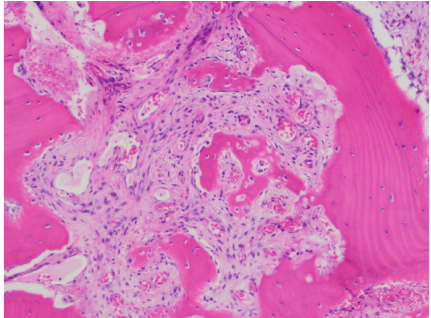
Figure 5: Photomicrograph showing osteoclastic bone resorption and fibrosis in secondary hyperparathyroidism (H&E, magnifica- tion × 200).